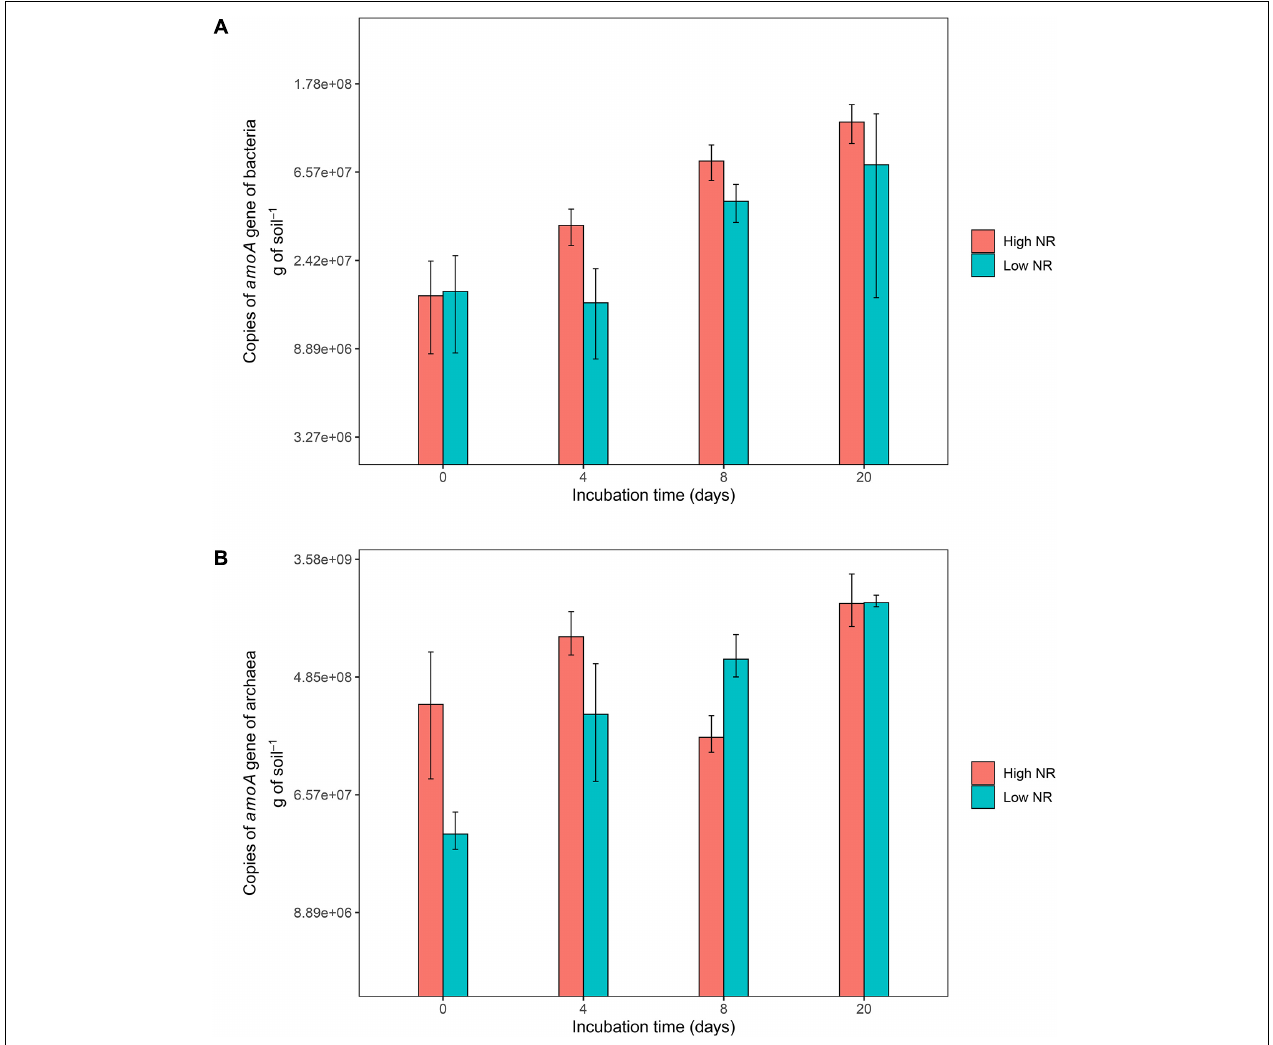
FIGURE 2 | Abundance of ammonia-oxidizing bacteria (A) and archaea (B) over different incubation time points in soils. Blue color corresponds to accessions of low nitrification rates whereas red color corresponds to accessions of high nitrification